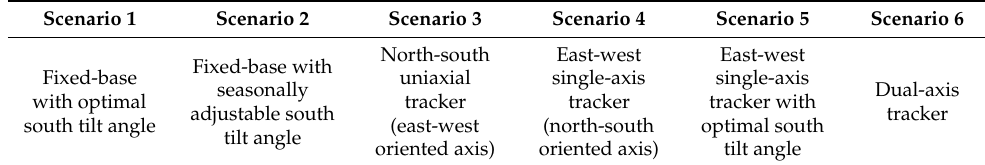
Table 8. Considered Scenario for